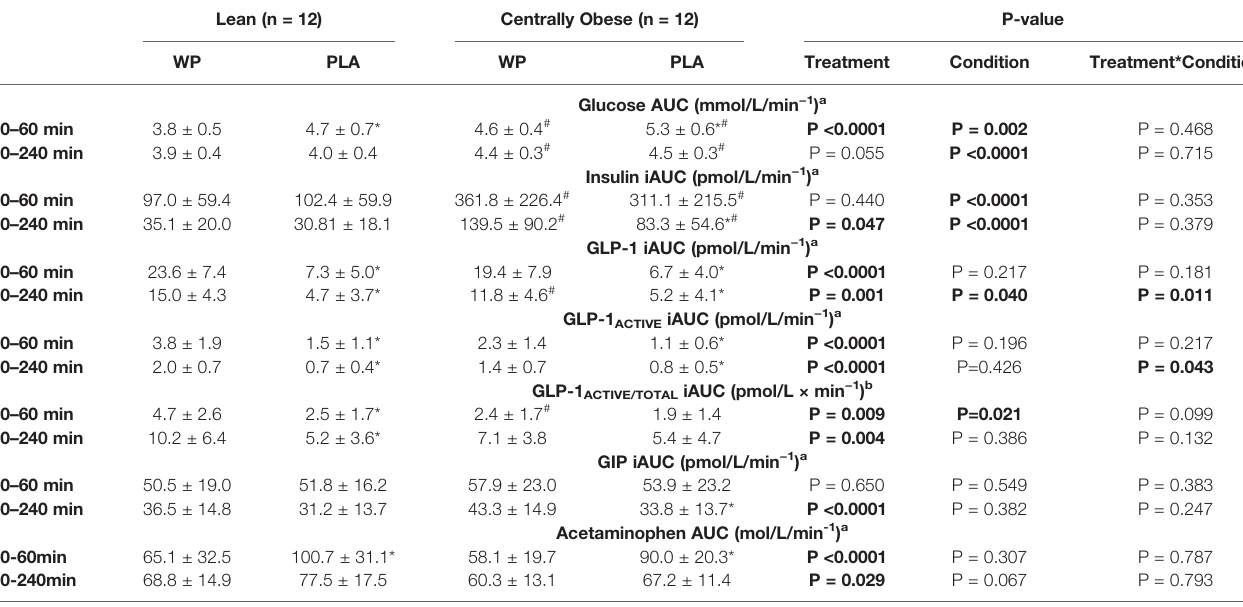
TABLE 2 | Postprandial area under the curve values of biochemical parameters during the mixed-meal tolerance test. Lean (n = 12) Centrally Obese (n = 12) P-value WP PLA WP PLA Treatment Condition Treatment*Condition Glucose AUC (mmol/L/min − 1 )